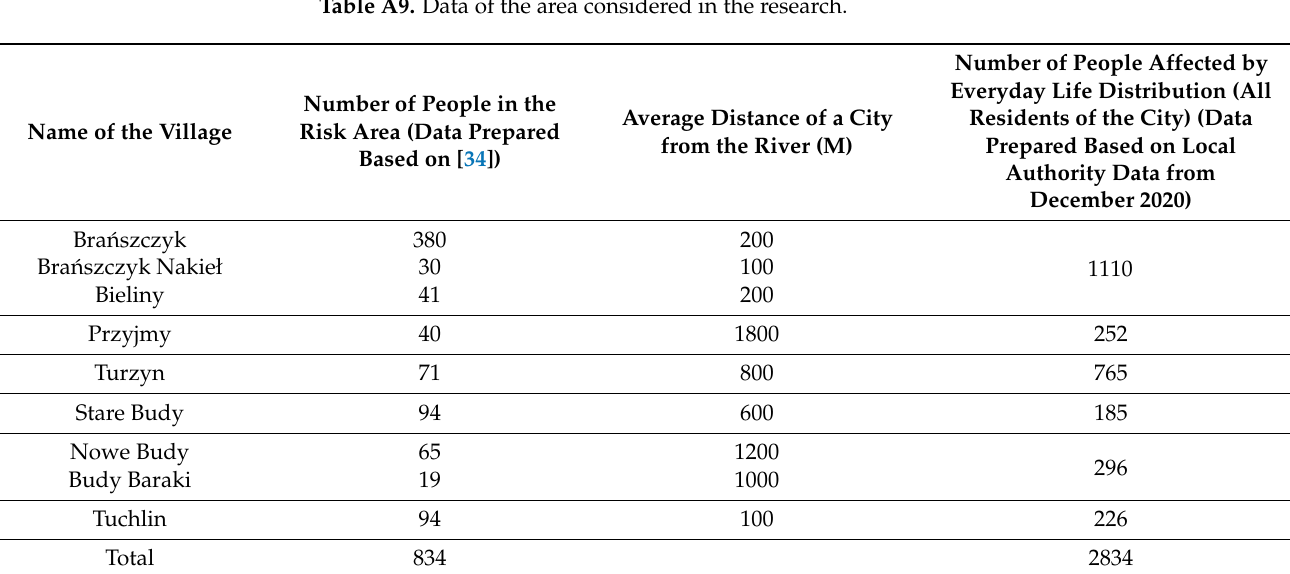
Table A9. Data of the area considered in the